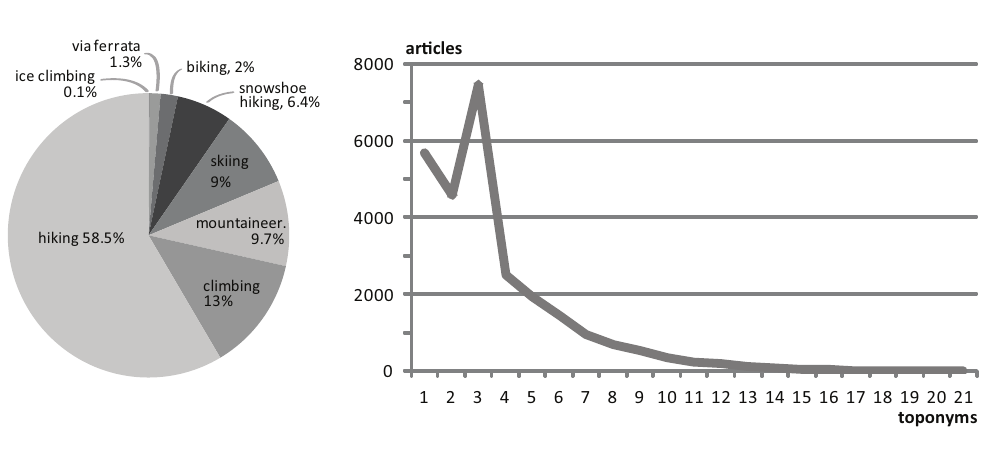
Figure 3: Metadata info on activities and waypoints per